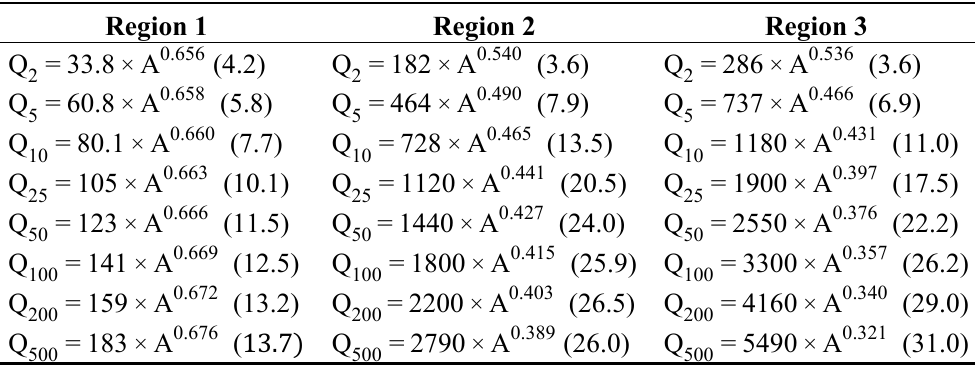
Table 4. Eash (2001) Single-Parameter USGS Regional Regression Equations for the State of Iowa [28]. (Equivalent years of record associated with the equations are shown in